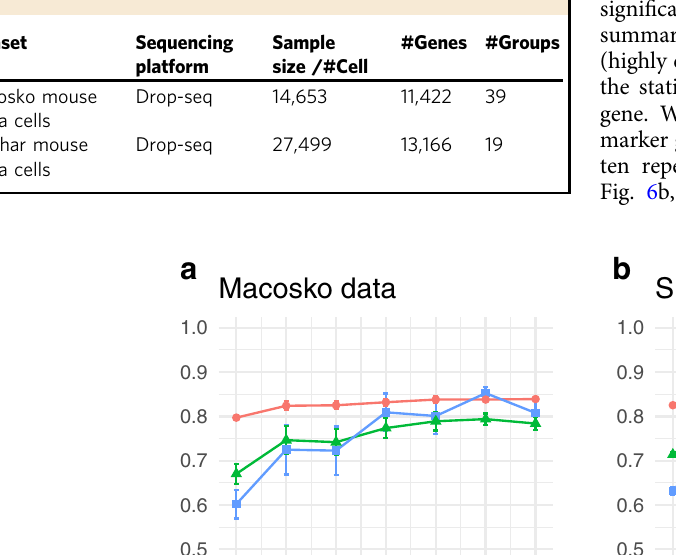
Table 2 Summary of two large scRNA-seq datasets.